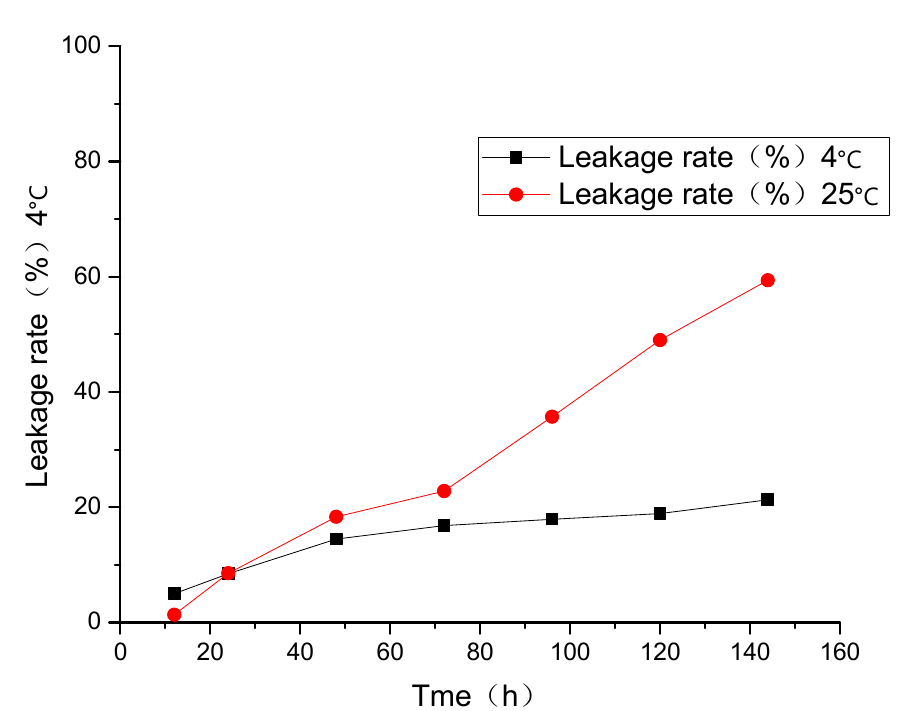
Figure 4. Leakage rate of AP-MVLs under different temperatures.